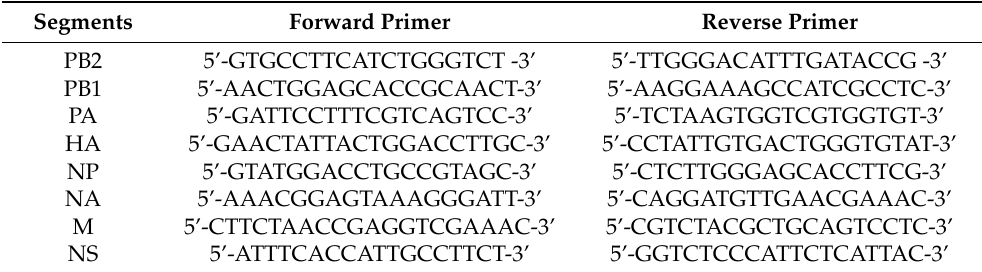
Table 1. Segment specific primers used for qPCR